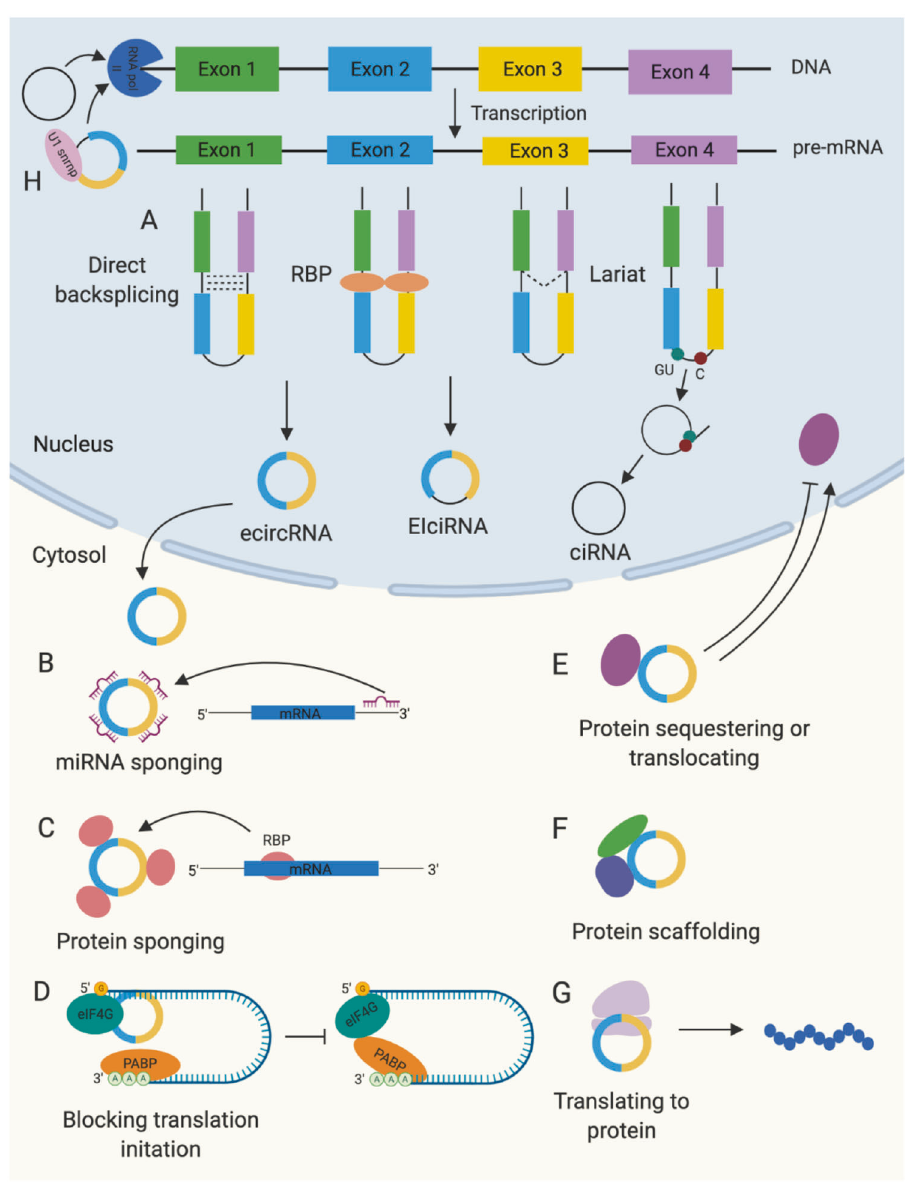
Fig. 1 Biogenesis and functional mechanisms of circular RNAs (circRNAs). A Back-splicing driven by the pairing of intronic complementary sequences, RNA-binding protein (RBP), or lariat structure containing skipped exons or introns. B Sponging microRNA (miRNA) to decrease their availability to bind target mRNA. C Sponging RNA-binding protein (RBP) to decrease their availability to bind target mRNA. D Interacting with eukaryotic translation initiation factor 4 G (eIF4G), poly(A)-binding protein (PABP), and cognate mRNA to disrupt the assembly of the translation initiation machinery. E Translocating proteins to the nucleus or sequestering them in the cytosol. F Facilitating interactions between speci fi c proteins. G Translating to protein in a cap-independent manner. H Exon-intron circRNAs (EIcircRNAs) can form a complex with the U1 small nuclear ribonucleoprotein (U1 snRNP) that binds RNA polymerase II (RNA pol II) to enhance transcription of parental genes. Intronic circRNAs (ciRNAs) can interact with elongating RNA pol II complex to enhance transcription of intronic complementary sequences. 41 After circularization, the intervening intron is removed to form ecircRNAs or retained to form EIcircRNAs. Alternatively, circRNAs can be generated through lariat-driven circularization. Exon-skipping during pre-mRNA pro- cessing produces a lariat structure containing the skipped exons. 42